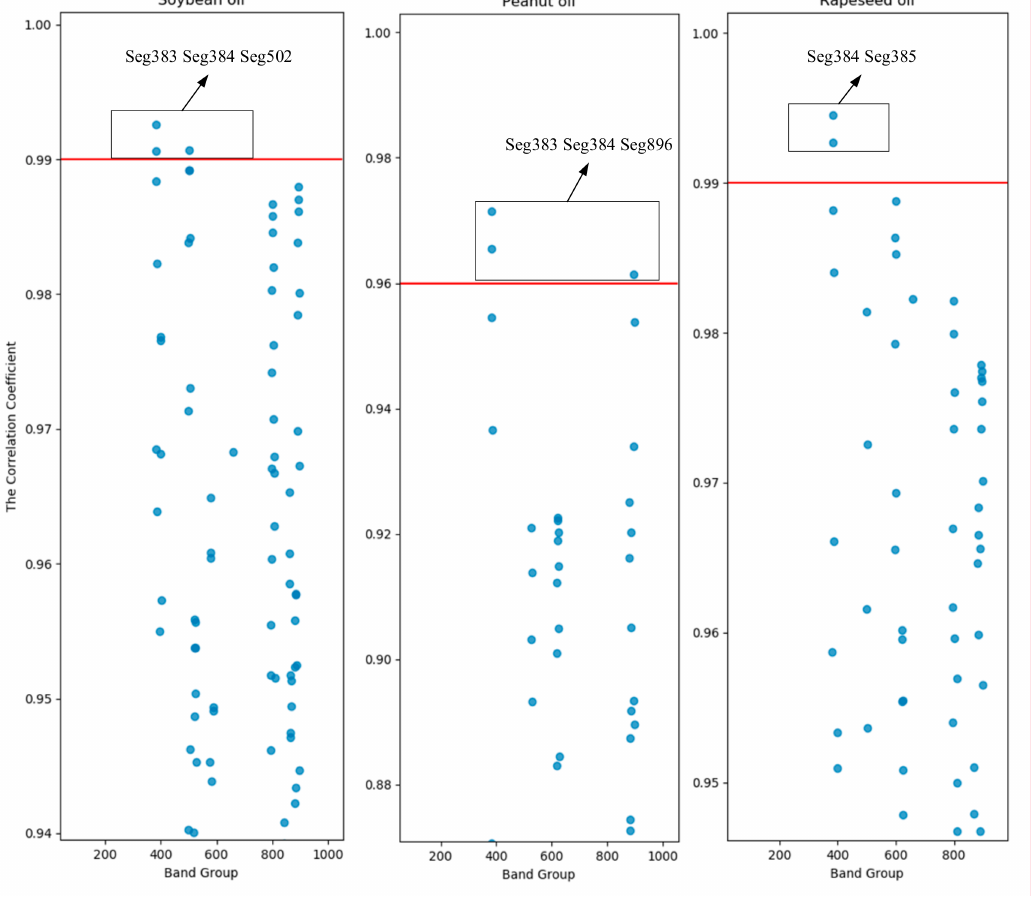
Figure 4. Scatter plot of correlation coe ffi cients for the first round of frying of three